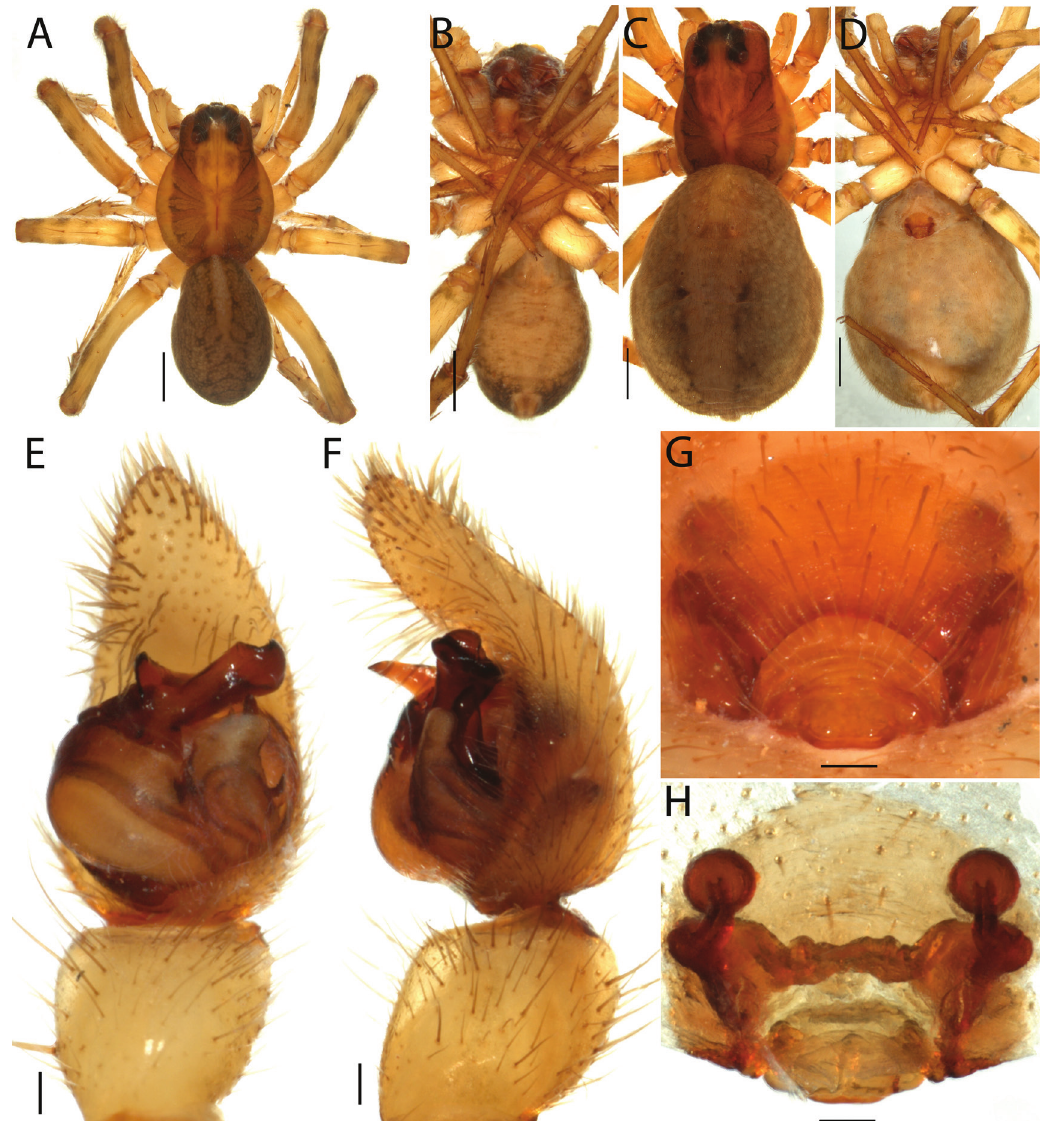
Figure 19. A flavimana Simon, 1909, male and female (AM KS52091): A , male habitus, dorsal view; B , male habitus, ventral view; C , female habitus, dorsal view; D , female habitus, ventral view; E, male pedipalp, ventral view; F , male pedipalp, retrolateral view; G , epigyne, ventral view; H , epigyne, dorsal view. Scale bars: habitus 1.0 mm; pedipalp, epigyne 0.1